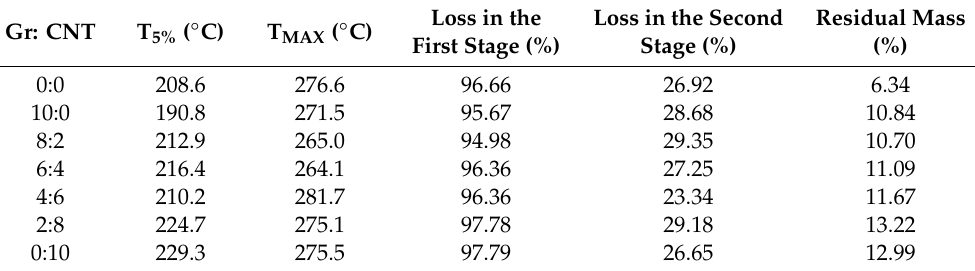
Figure 8. Characterization of thermal properties of PVA / SA / Gr / CNT nanofiber membranes: ( a ) DSC of nanofibrous membranes as related to Gr-CNT ratios, and ( b ) TG of nanofibrous membranes as related to Gr-CN ratios. Table 3. DSC and TG results of nanofiber